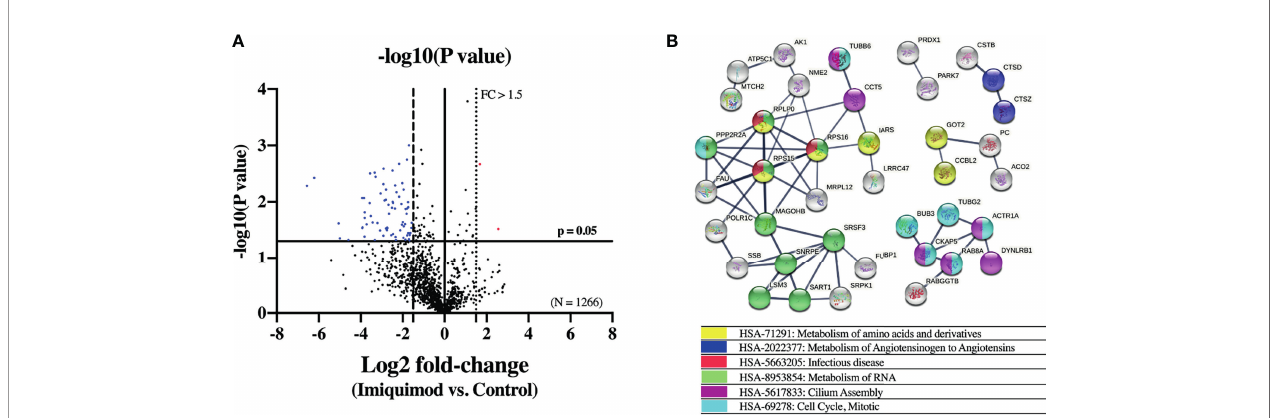
FIGURE 3 | Imiquimod treatment modi fi es the proteome of human bronchial epithelial cells (HBECs) from patients with asthma. (A) Volcano plot showing differentially expressed proteins between imiquimod treated and control unstimulated HBECs from patients with steroid-free asthma (N = 3). Proteins down-regulated (blue dots; log2 fold-change < -1.5, p < 0.05) and up-regulated (red dots; log2 fold-change > 1.5, p < 0.05) are depicted. (B) STRING interaction network of the proteins down-regulated by imiquimod treatment. Only proteins interacting with high con fi dence score (0.700) are shown. Colors represent the most relevant enriched Reactome